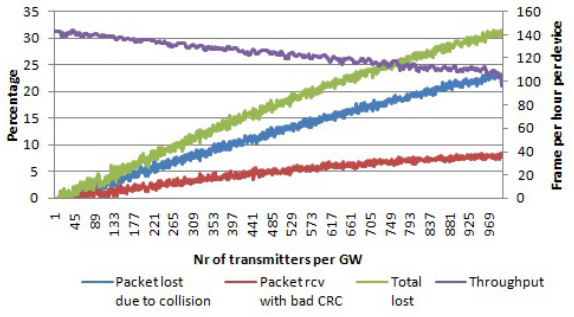
Figure 9. Percentage of packets lost due to collisions and the percentage of packets received with the wrong payload CRC per number of transmitters per gateway. Average throughput per device. Payload size 20 bytes, multiple channels, multiple SFs.